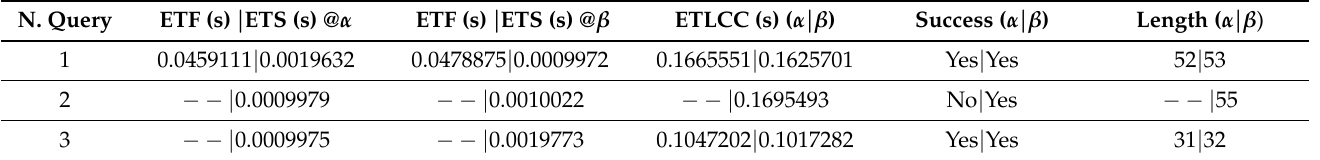
Table 4. Execution time of case study 1 (3 DOF manipulator). ETF: execution time spent in the incomplete LU factorization, ETS: execution time spent to solve linear system using ILU factors, ETLCC: execution time spent in the LCC algorithm, α : ILU tolerance = 1 × 10 − 3 , β : ILU tolerance = 1 × 10 − 6